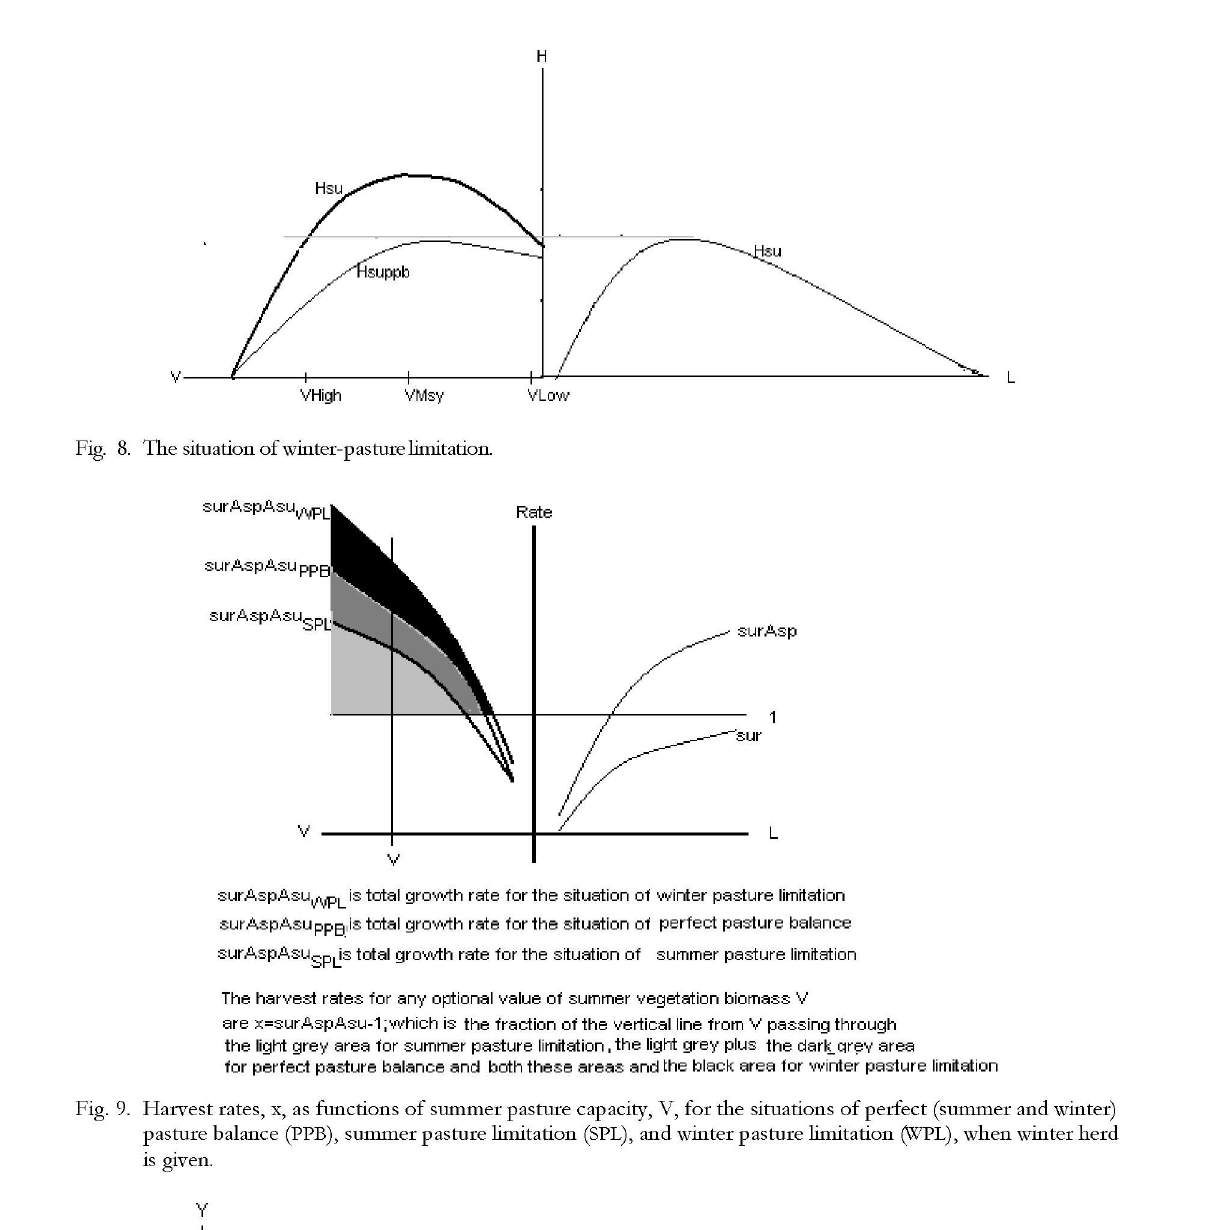
Fig. 8. The situation of winter-pasture limitation.